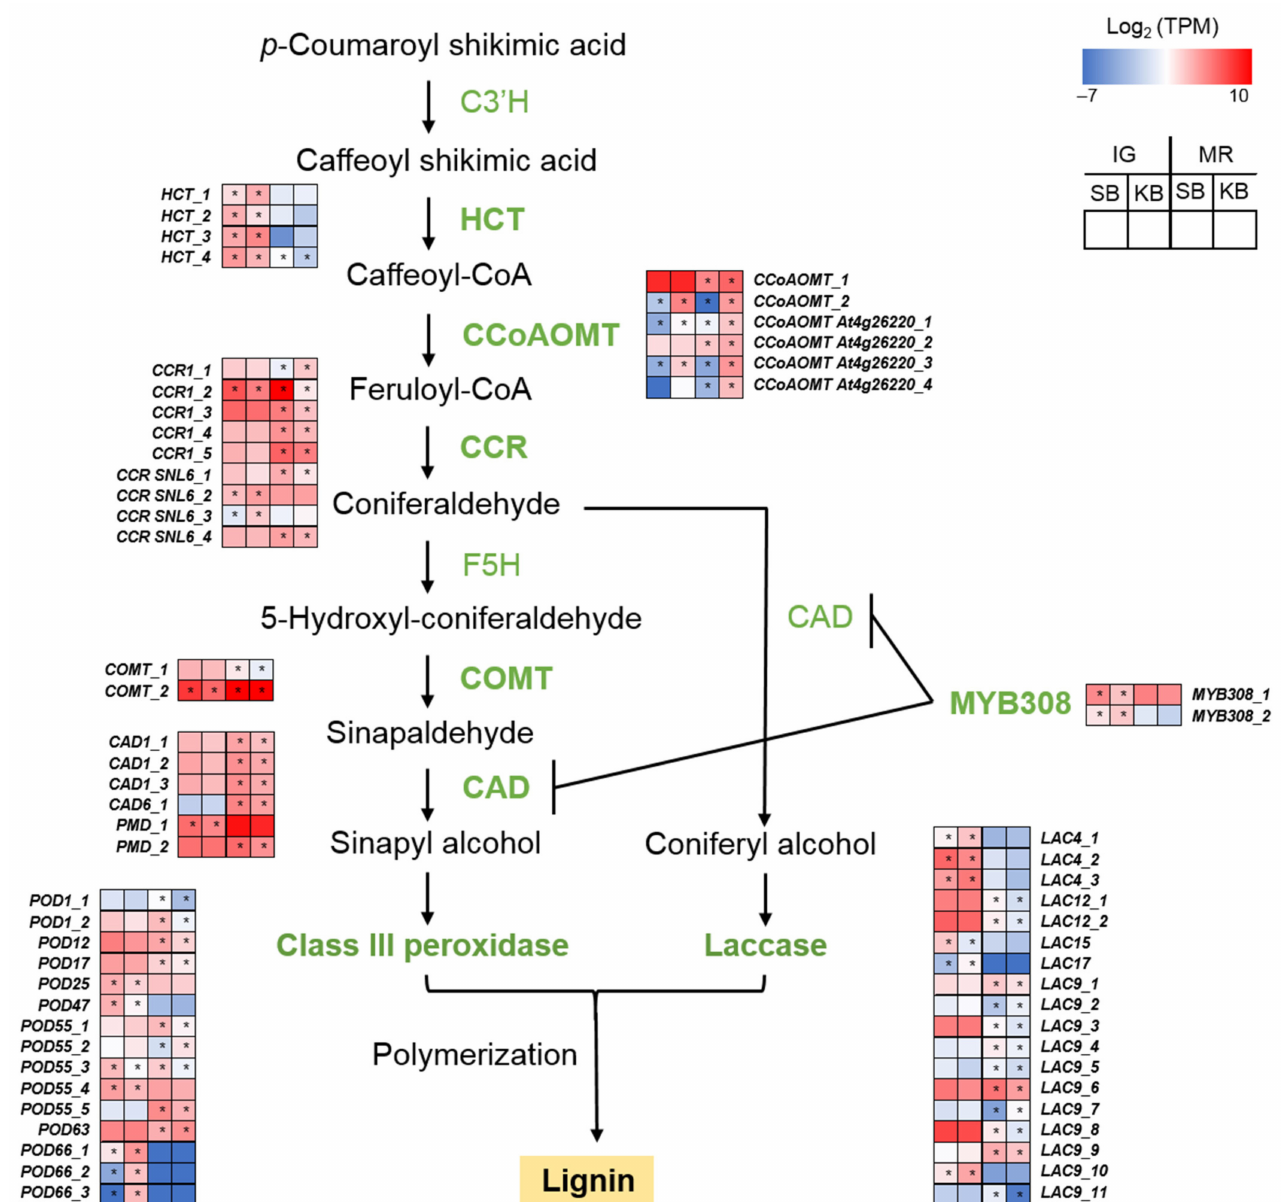
Figure 3. Lignin biosynthesis gene expression patterns at IG and MR of “Sunnyberry” and “Kingsberry” strawberry fruit. C3’H, p -coumaroyl shikimate 3’-hydroxylase; CAD, cinnamyl alcohol dehydrogenase; CCoAOMT, caffeoyl-CoA O - methyltransferase; CCR, cinnamoyl-CoA reductase; COMT, caffeic acid O -methyltransferase; F5H, ferulic acid 5-hydroxylase; HCT, shikimate O -hydroxycinnamoyltransferase; IG, immature-green; KB, “Kingsberry” cultivar; LAC, laccase; MR, mature- red; PMD, probable mannitol dehydrogenase; POD, peroxidase; SB, “Sunnyberry” cultivar; TPM, transcripts per million. Asterisks indicate statistically significant differences between cultivars (FDR p < 0.01; |Fold change| >